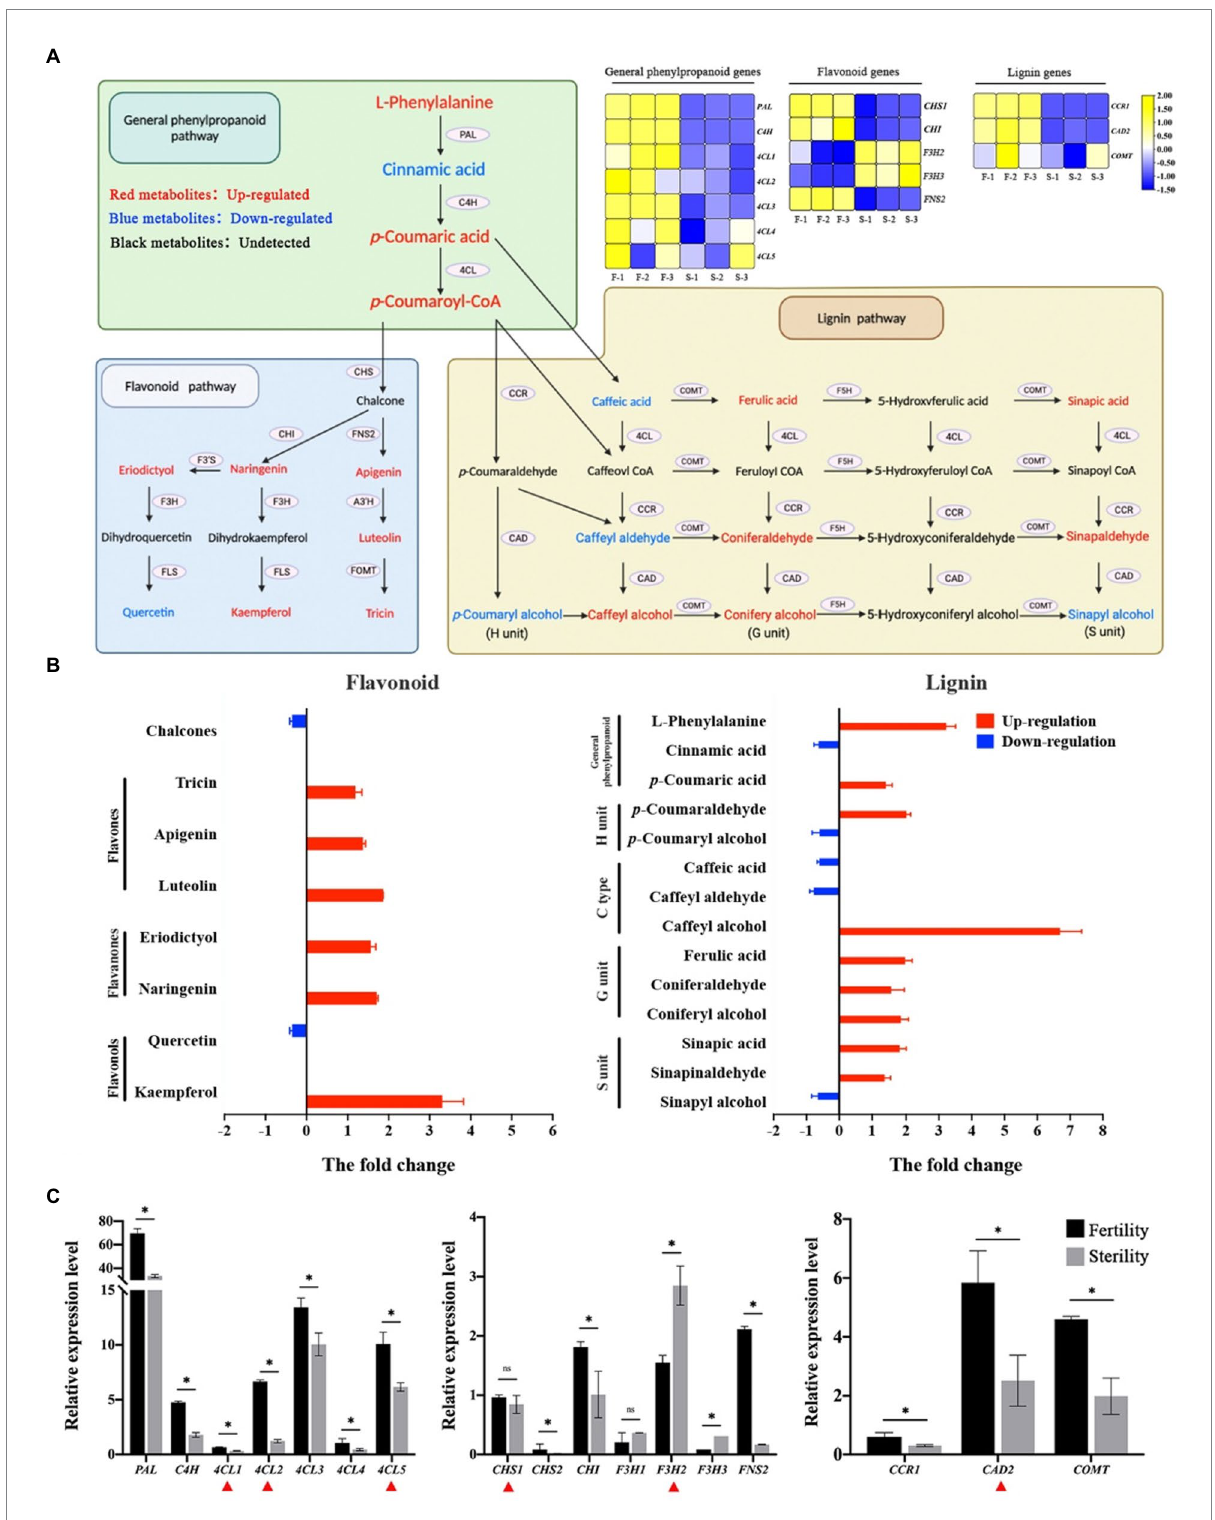
FIGURE 6 Differences in phenylpropanoid metabolism were compared in fertile and sterile anthers. (A) Metabolic pathways and critical gene expression of phenylpropanoid in rice. (B) The changes of flavonoids and lignin metabolites in the comparison group. (C) Expression of critical genes in phenylpropanoid metabolism in fertile and sterile anthers by qPCR. In A , the Heatmap shows the transcriptome data of critical genes. Red metabolites indicated up-regulated substances and blue metabolites indicated down-regulated substances. In B , the Y -axis indicates the different substances and the X -axis indicates the fold change in the comparison group of fertile and sterile plants. Red bars indicate that the substance is upregulated in fertile plants and blue bars indicate that the substance is downregulated in fertile plants. In C , the qPCR results show the average of three replicates. * p < 0.05. ns, Not significant. The red triangles indicate the DEGs in